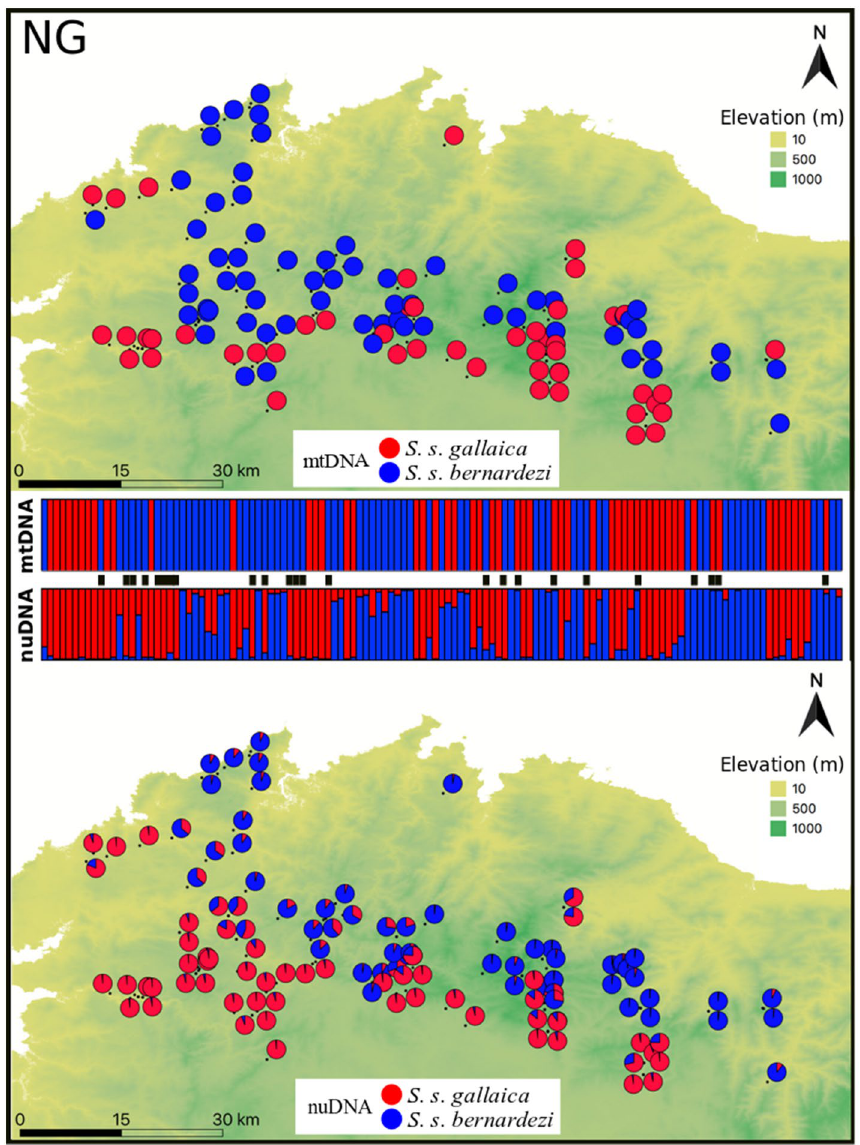
Figure 2. Genetic structure of S. salamandra across northern Galician populations (NG) as inferred by both mitochondrial (upper panel; two main lineages separating S. s. bernardezi and S. s. gallaica ) and nuclear DNA (lower panel; STRU CTU RE K = 2). Samples in the barplots are arranged from west to east. Genetic assignment to S. s. bernardezi or S. s. gallaica is colour-coded in blue and red, respectively. Black bars between structure plots indicate individuals with mitonuclear discordance (19%). The figure was created with QGIS software (version 3.2; https:// qgis. org/ en/